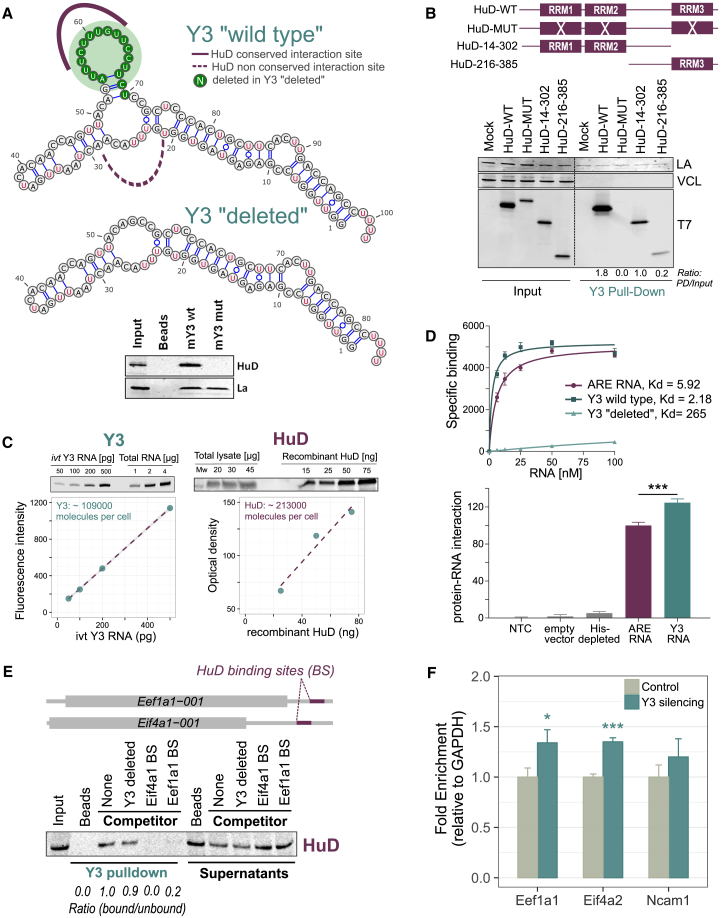
Y3 Competes for HuD Association with Target mRNAs(A) Upper panel: secondary structure of Y3 with HuD interaction sites (visualized with VARNA) based on chemical probing. Center panel: representation of the Y3 “deleted” variant, obtained by eliminating the conserved HuD binding region. Lower panel: His-HA-HuD was induced in NSC-34 cells. Lysates were subjected to RNA pull-downs with biotinylated Y3, followed by immunoblot for HuD and La proteins. Either the wild-type Y3 sequence or the mutant that lacks the HuD binding site was used.(B) Y3 RNA-pull-down showing that HuD interacts with Y3 by the RRM domains, mainly RRM1 and RRM2.(C) Quantification of Y3 and HuD molecule number in NSC-34 cells. The estimated molecule number was calculated by means of a calibration plot generated by known amounts of standards, i.e., in vitro-transcribed (ivt) Y3 RNA and recombinant HuD, respectively.(D) Upper panel: saturation binding curves of recombinant HuD protein as function of increasing amount of RNA probes. Kd values were obtained by non-linear regression analysis. Three independent experiments were performed. Lower panel: AlphaScreen assay using ARE and Y3 RNA probes with lysates of NSC-34 cells expressing HuD protein. Two independent experiments were performed at the hooking point with 50 nM of RNA probes.(E) HuD was induced in NSC-34 cells. Lysates were prepared and RNA pull-downs with biotinylated Y3 were conducted either without (none) or with competitor RNAs included in the extract (7× molar excess).(F) RIP assay of HuD binding to Eef1a1, Eif4a2, and Ncam1 mRNAs after Y3 silencing; data were normalized to Gapdh mRNA levels in each IP.In (D) and (F), data are represented as mean ± SEM t test ∗p < 0.05 and ∗∗∗p < 0.001.See also Figure S4.